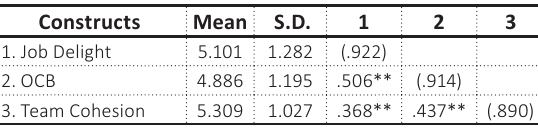
Table 1. Descriptive statistics,